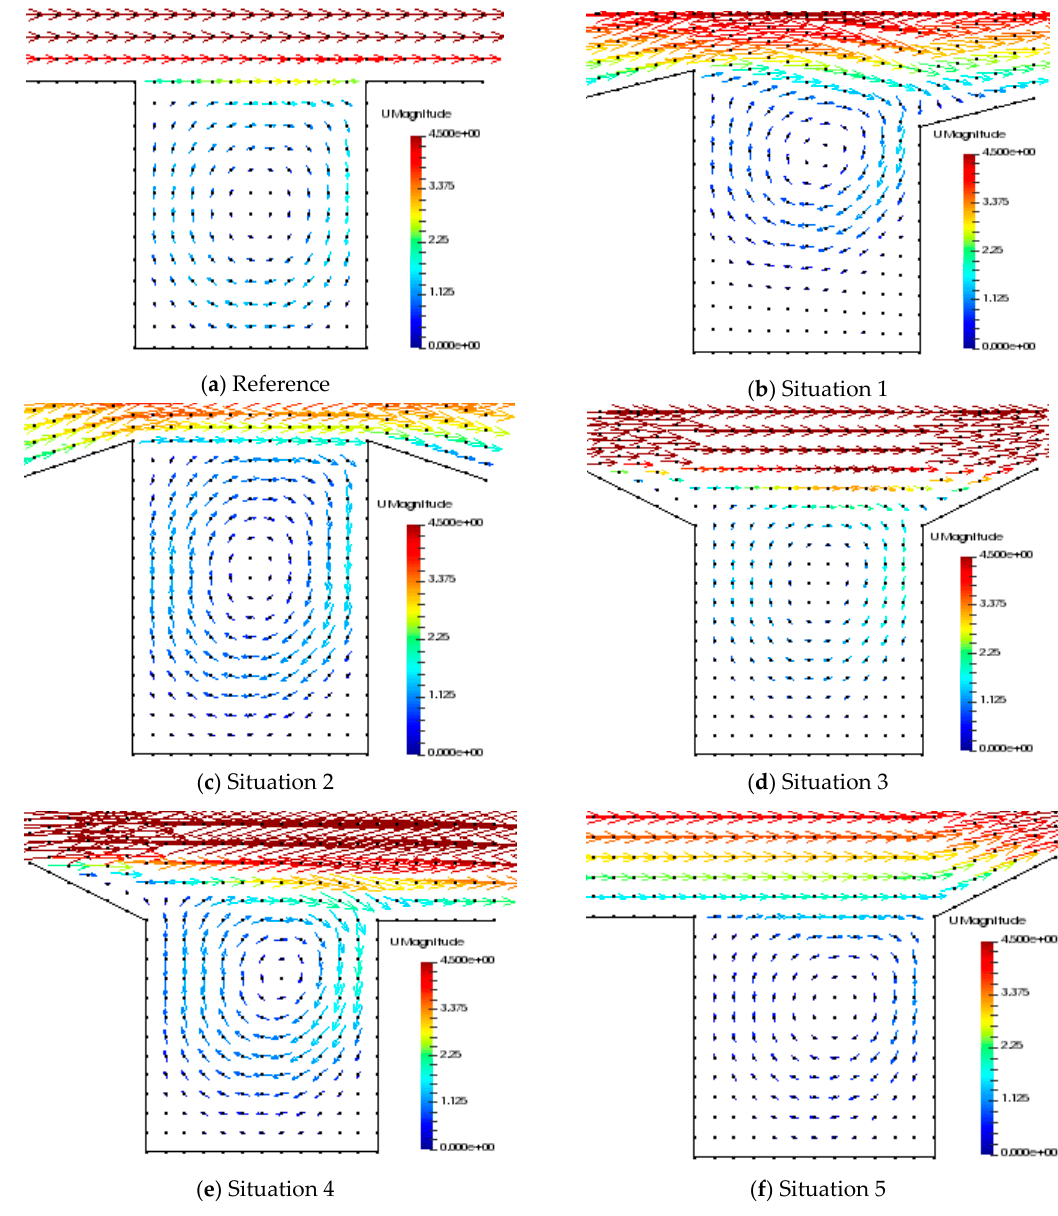
Figure 23. Velocity vector of wind flow inside the street canyons with different roof shape configurations. ( a ): Reference case, ( b – f ): Situation 1–5.